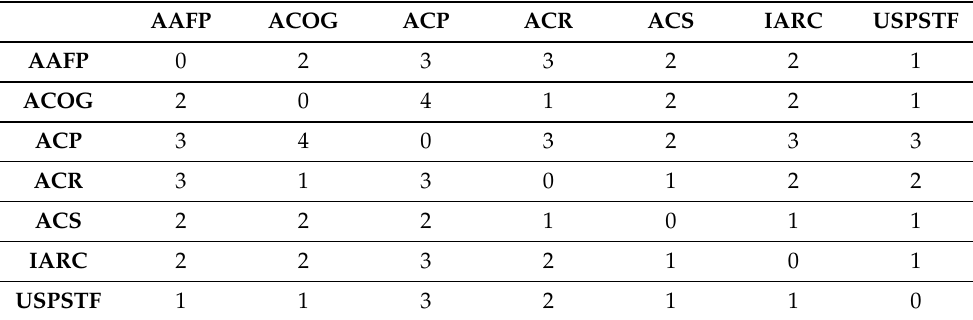
Table 2. This table shows the number of differing feature values for pair of guidelines, based on Table 1. The Jaccard distances between the documents are obtained by dividing the value in the table by five (the number of